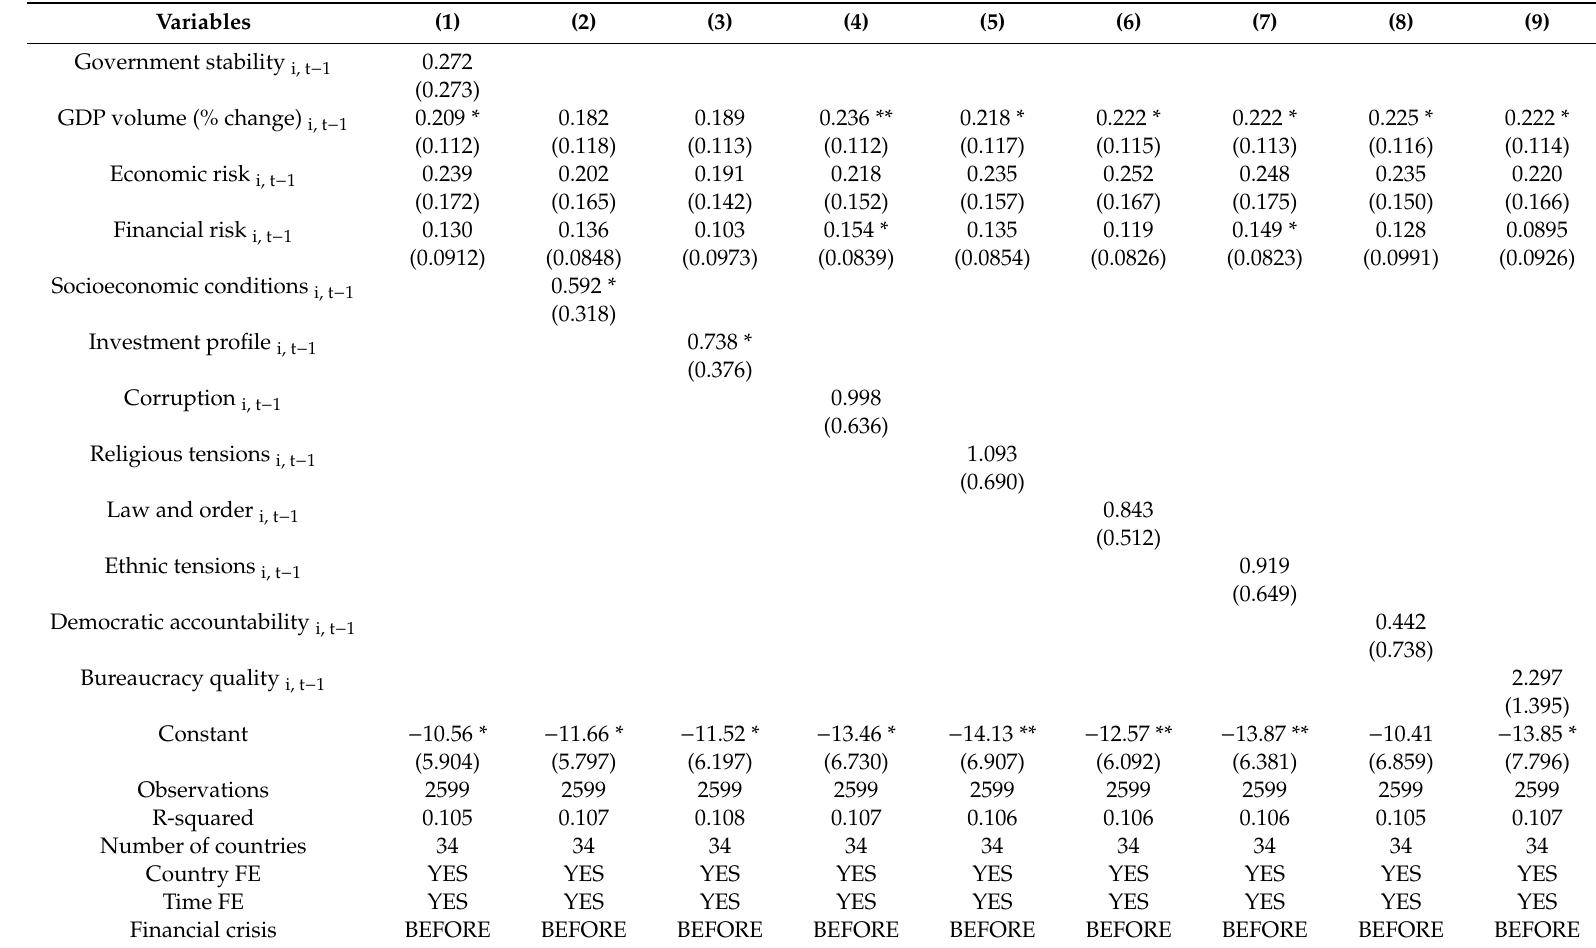
Table A7. Estimation results for OECD countries—components of political stability (before financial